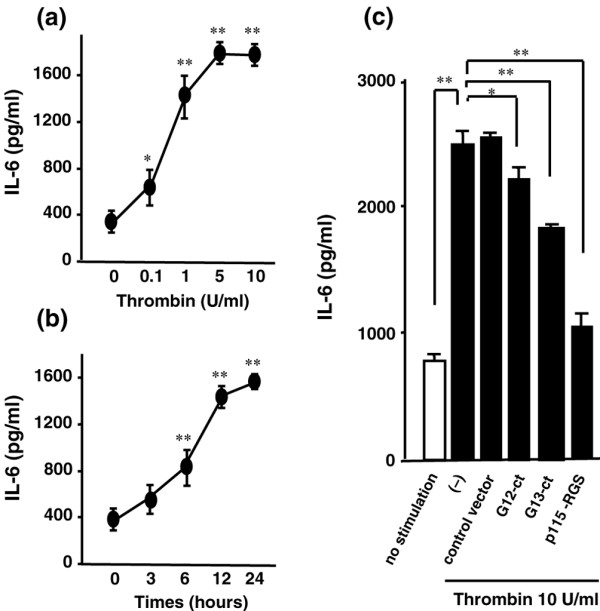
Thrombin induces IL-6 secretion via Rho-mediated signaling in RA synovial fibroblasts. Rheumatoid arthritis (RA) synovial fibroblasts (SFs) were or were not infected with adenoviruses encoding green-fluorescent protein (control vector), the C-terminal regions of Gα12 (Gα12-ct), Gα13-ct, or p115RGS. Cells were cultured for 48 hours in DMEM containing 1% FCS, then stimulated with the indicated amount of thrombin. At 3 to 24 hours after thrombin stimulation, the supernatants of cultured cells were collected and assayed for IL-6 using commercial ELISA kits. (a) Dose-dependent IL-6 production by RA SFs at 12 hours after thrombin stimulation. (b) Time course of IL-6 secretion by RA SFs stimulated with 10 units/ml thrombin. (c) Effect of Rho signaling inhibition on thrombin-induced IL-6 secretion at 12 hours after thrombin stimulation. Data are expressed as mean ± standard deviation of five experiments, using five independent donors. (-), cells without infection; p115RGS, regulator of the G-protein signaling domain of p115Rho guanine nucleotide exchange factor. *P < 0.05, **P < 0.01, in comparison with (a) time 0, (b) no thrombin stimulation, and (c) the indicated data.